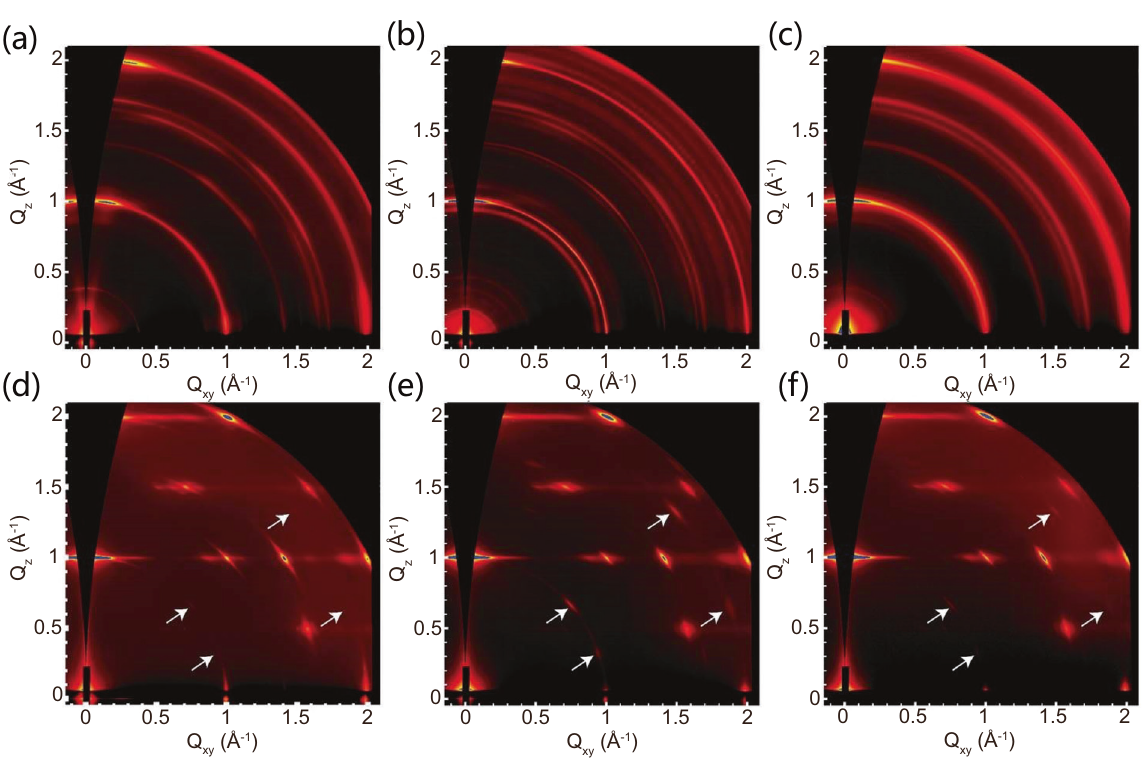
Fig. 5 GIWAXS patterns for drop-cast PEA-2D and iso-BA-2D perovskite fi lms. a Naturally dried PEA-2D fi lm; b N 2 blow-dried PEA-2D fi lm; c N 2 blow- dried PEA-2D fi lm with MACl additive; d naturally dried iso-BA-2D fi lm; e N 2 blow-dried iso-BA-2D fi lm; f N 2 blow-dried iso-BA-2D fi lm with MACl additive.